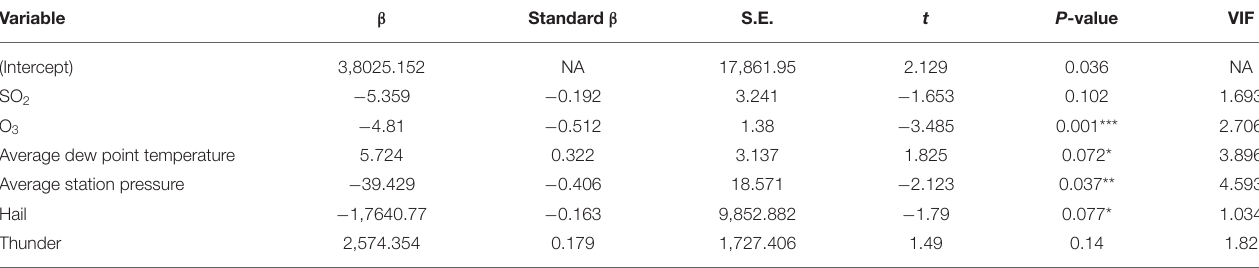
TABLE 2 | Multivariate meta-regression